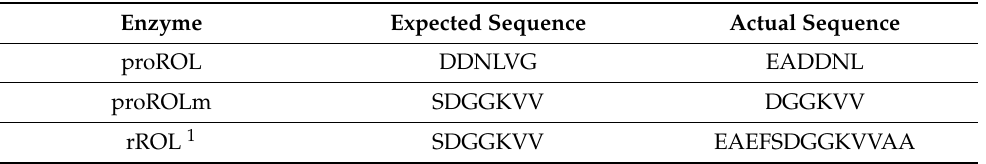
Table 3. Expected sequence for the N-terminal based on the cloned sequence and actual sequence as determined by Edman’s degradation